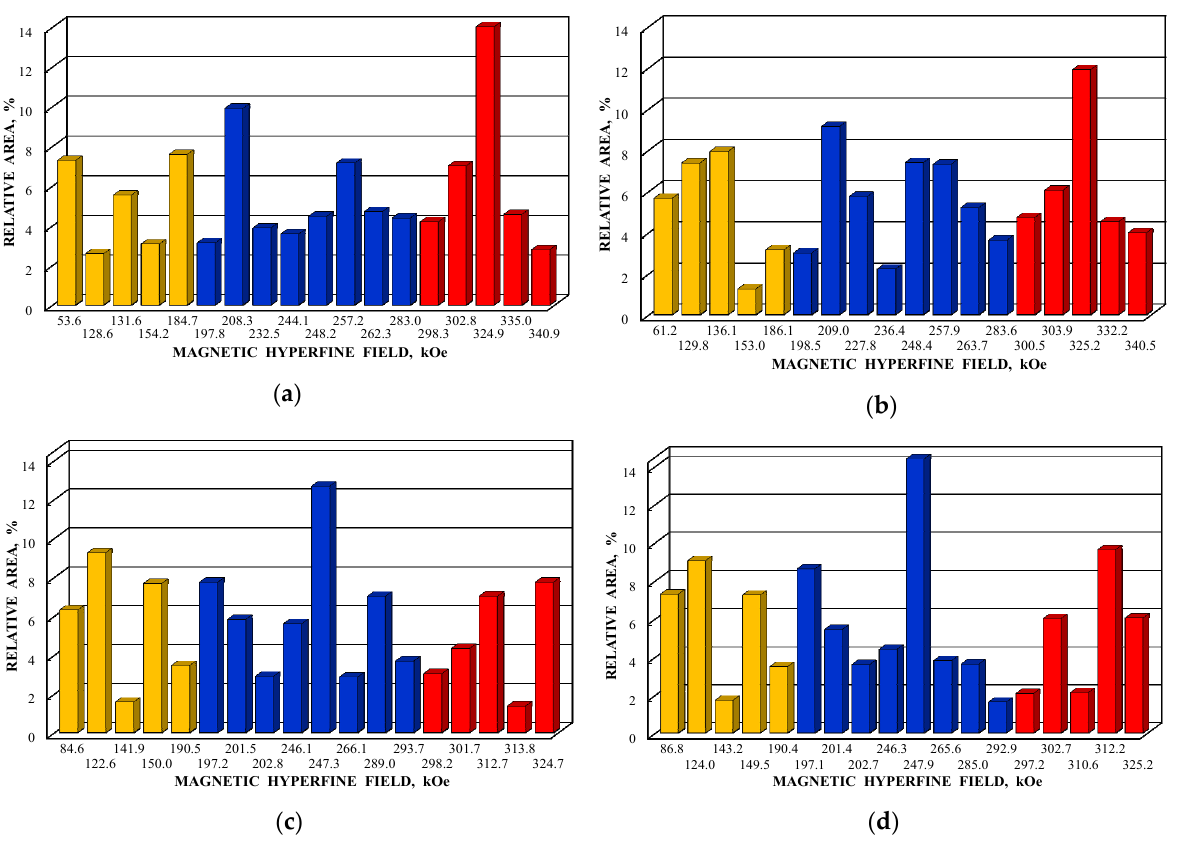
Figure 80. Histograms of the relative areas of the magnetic sextets revealed from the decomposition of the Mössbauer spectra of FINEMET ribbons with different permeabilities: FT1, μ r = 1350 ( a ), FT2, μ r = 6000 ( b ), F1, μ r = 34,500 ( c ) and F2, μ r = 190,000 ( d ) using 18 magnetic sextets vs. H eff increase. ■ are magnetic sextets associated with different iron local microenvironments in the amorphous phase, ■ are magnetic sextets assigned to different iron local microenvironments in the crystalline sublattice D and are magnetic sextets related to different iron local microenvironments in the crystalline sublattice A.